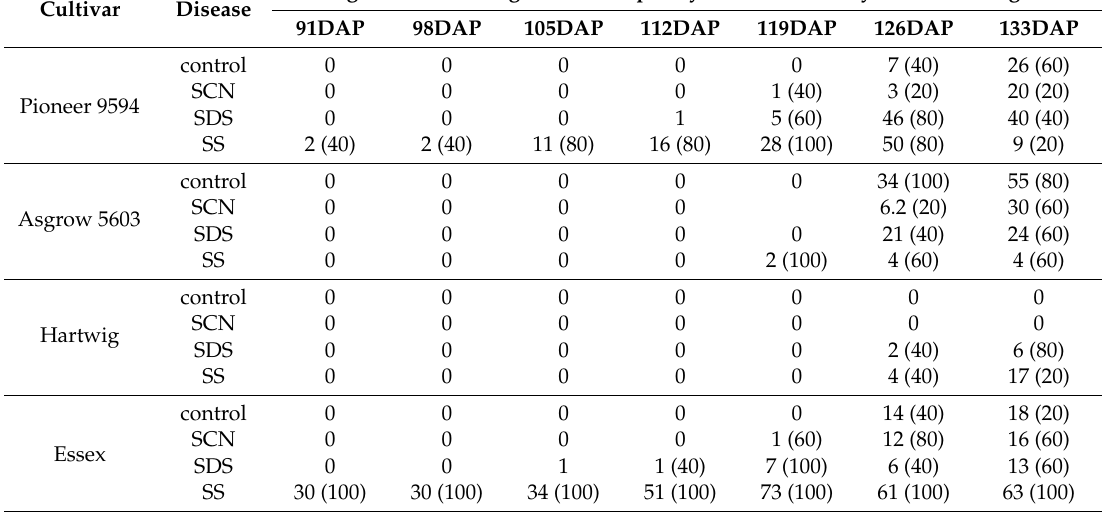
Table 3. Disease infestation statistics for different cultivars under the 4 disease treatments of control (no disease), sudden death syndrome (SDS), soybean cyst nematode (SCN), and SCN + SDS (SS). Each cultivar × disease combination had 5 observations. Values in parentheses indicate percentage of infested plots in the specific